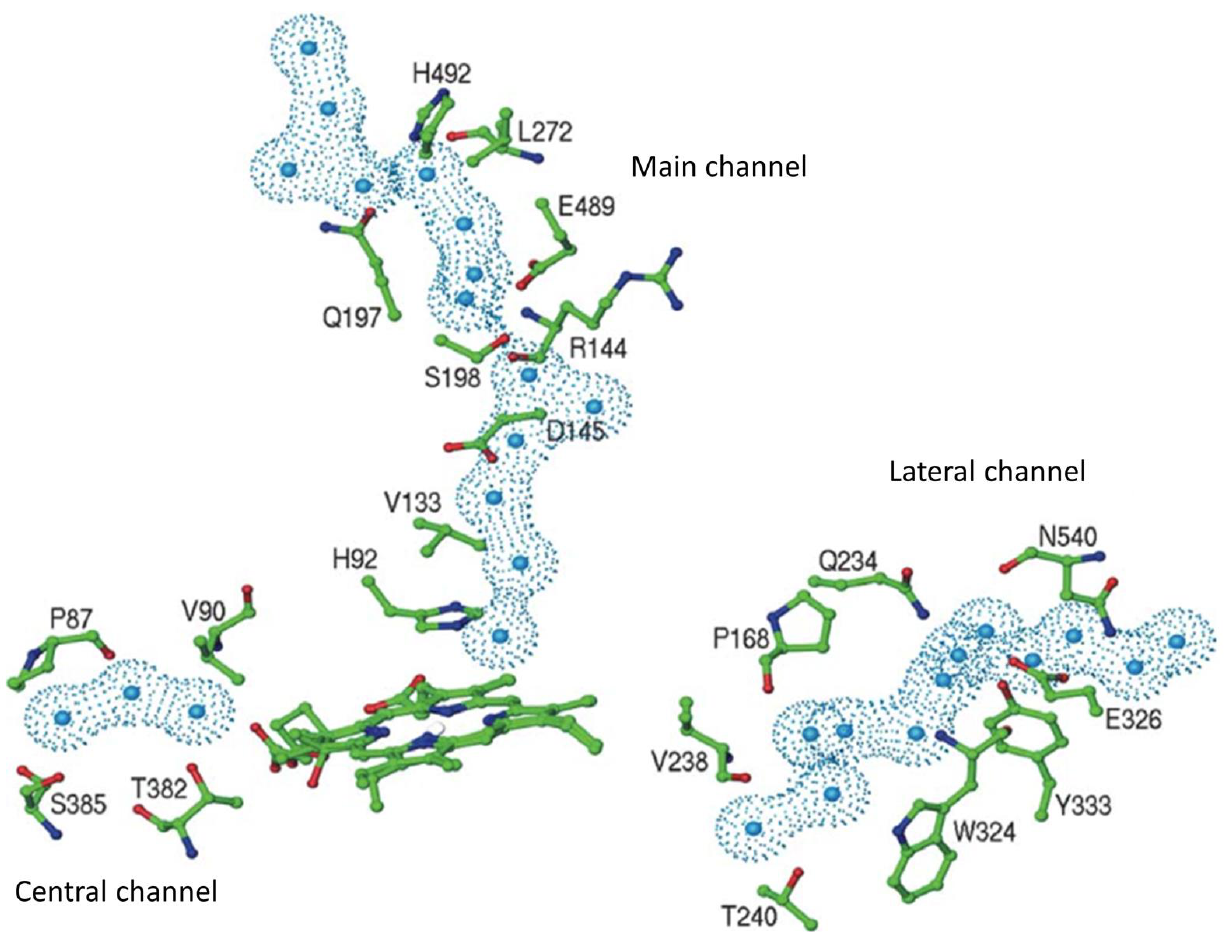
Figure 4. Water molecules and some of the residues lining the main channel, the lateral channel, and the central channel of CAT-1. Only the first three water molecules of the central channel are shown, the second three are already in the central cavity. Water molecules have a radius of 1.4 Å. Reprinted with permission from [41] 2004, Elsevier.